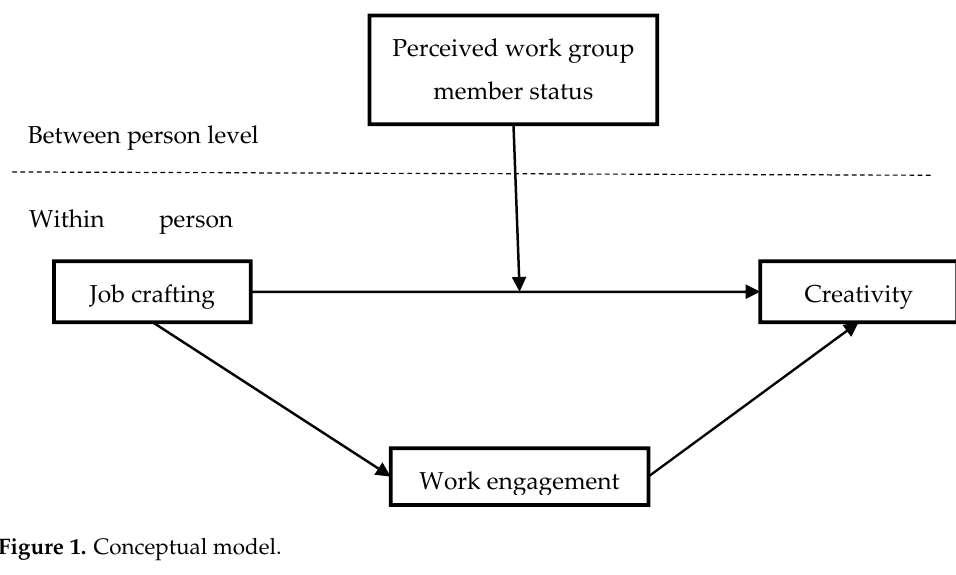
Figure 1. Conceptual model.